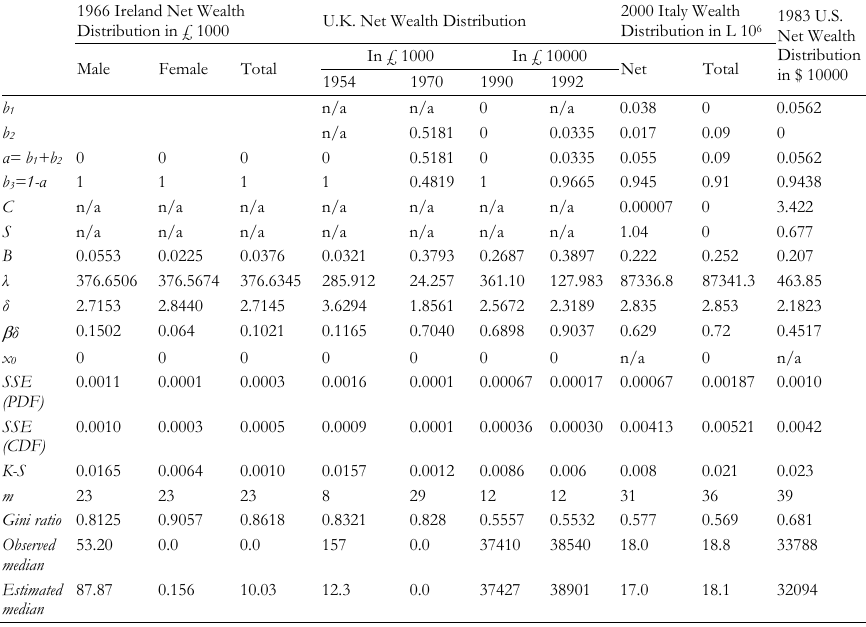
Fitting the Dagum model to the wealth distribution in Ireland, the U.K., Italy and the